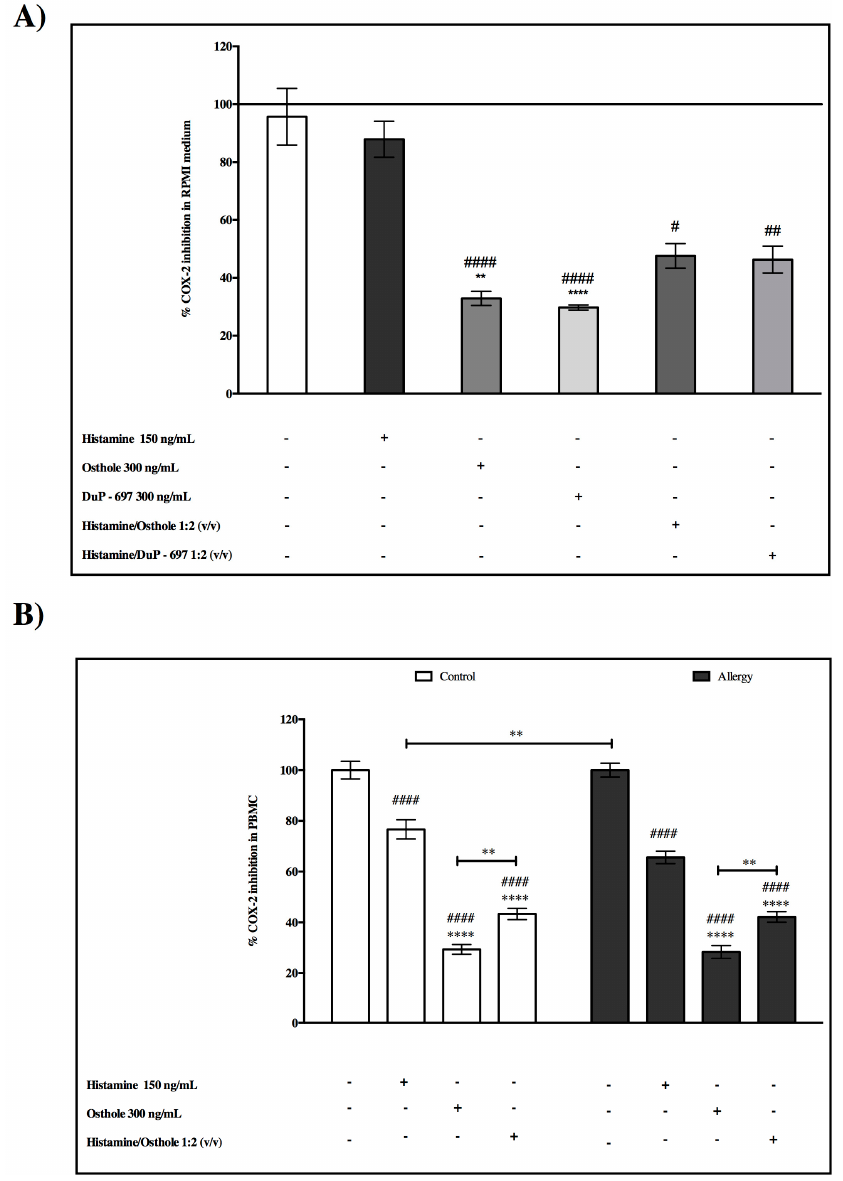
Figure 5. Activity of COX-2 after incubation with tested substances ( A ) in medium, and ( B ) in PBMC from the control and allergy groups. Data are presented as the mean ± S.E.M. #### p < 0.0001 vs. control; ** p < 0.01, **** p < 0.0001 vs. treated histamine